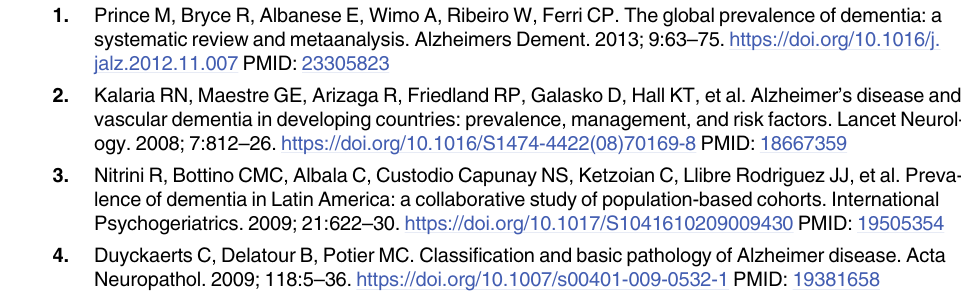
S3 Table. Association between neuropathological lesions and dementia status ( n = 1,092). S4 Table. Association between NPC score and cognitive outcomes ( n =